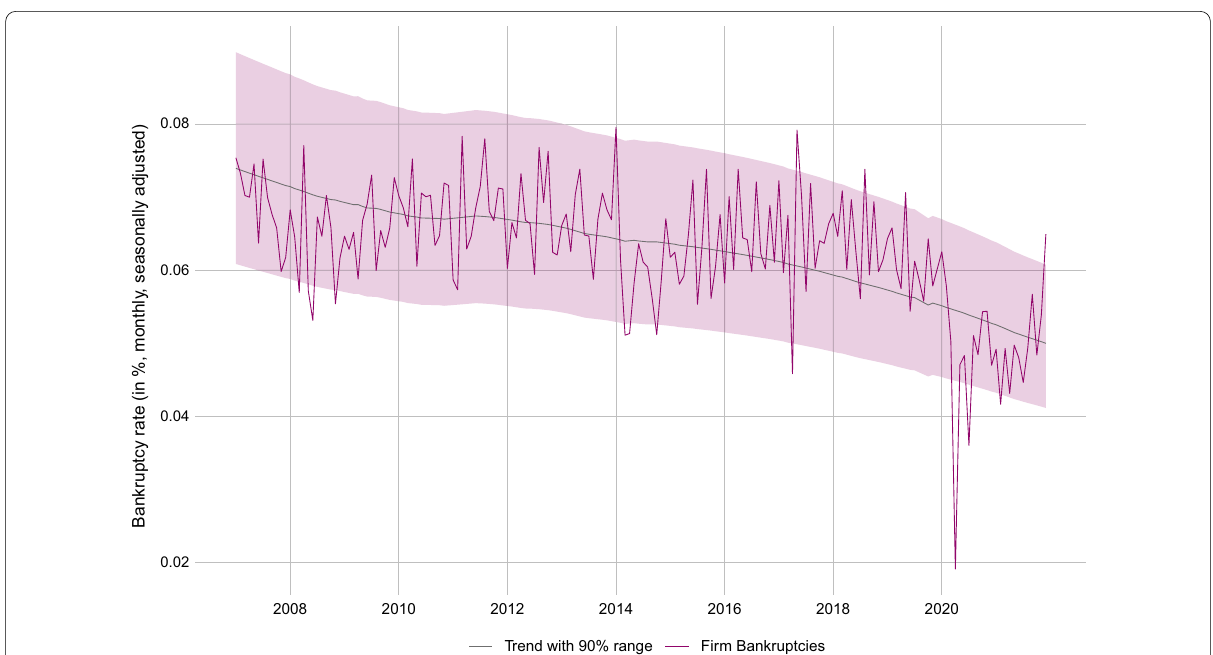
monthly seasonally adjusted =